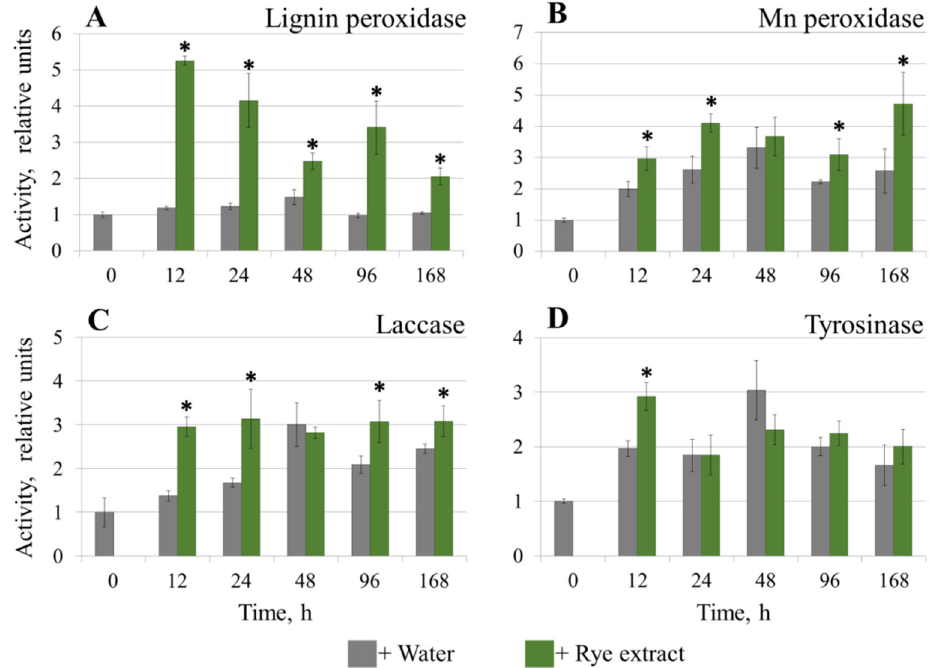
Figure 6. The effect of the extract of rye leaves on the extracellular activities of lignin peroxidase ( A ), Mn peroxidase ( B ), laccase ( C ), and tyrosinase ( D ) of the Microdochium nivale strain 1. Fungal cultures (grown for 20 days in minimal medium) were supplemented with rye extract (green columns) or water (gray columns), and then the enzymatic activities were measured. The values are given relative to the zero point (before the addition of rye extract or water), the activities at which were equated to one. The presented values are averages ± SD of five biological replicates. The stars show significant differences (Mann–Whitney U test, p -value < 0.05) between samples with and without rye extract.